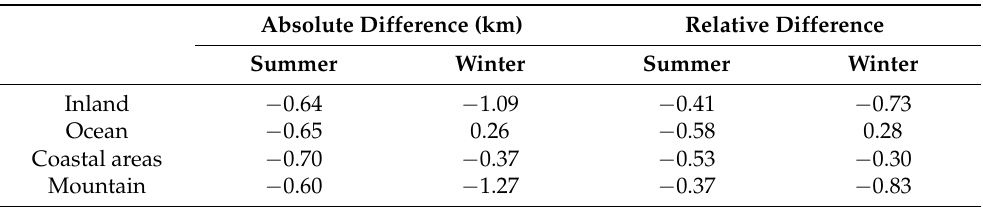
Table 2. Mean difference in BLH derived from AD-Net and ECMWFs (ECMWFs BLH minus AD-Net BLH) in summer and winter. Absolute Difference (km) Relative Difference Summer Winter Summer Winter Inland − 0.64 − 1.09 − 0.41 − 0.73 Ocean − 0.65 0.26 − 0.58 0.28 Coastal areas − 0.70 − 0.37 − 0.53 − 0.30 Mountain − 0.60 − 1.27 − 0.37 − 0.83